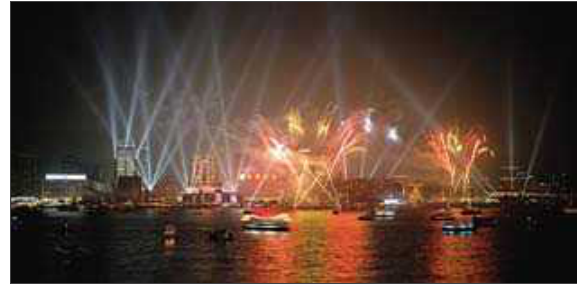
Fig. 9. hong kong Symphony of Lights,